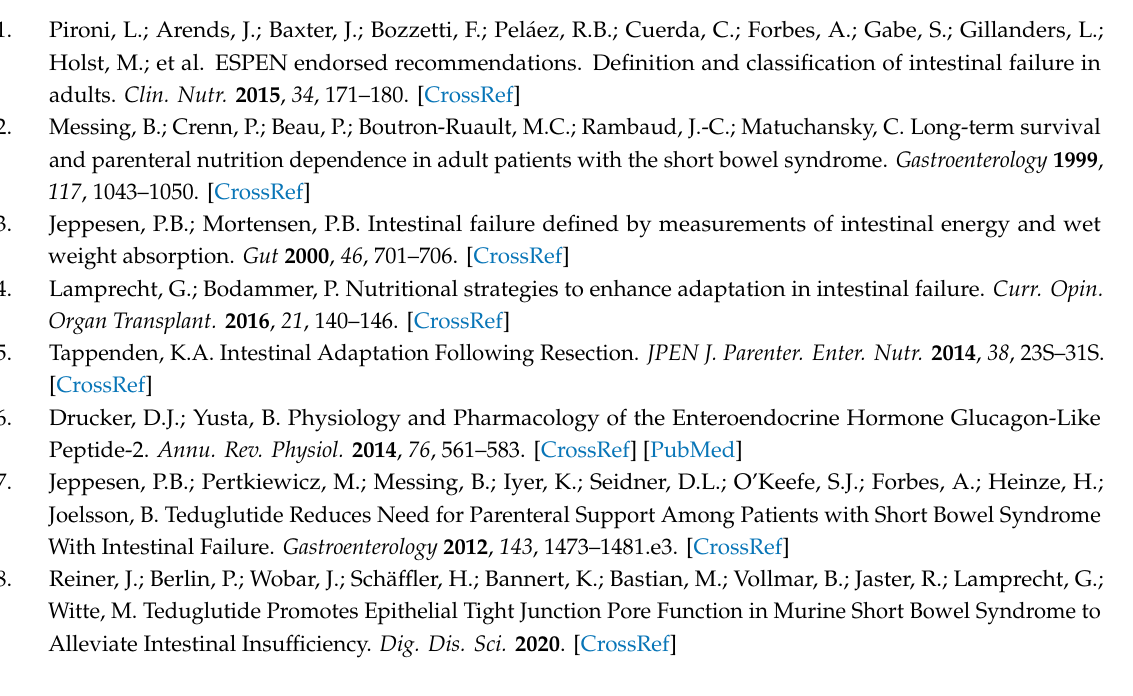
Figure A3: Urine sodium concentrations were available from 28 of 50 patients and were compared between the earliest and the latest measurement (similar to FIRST and LAST). ( A ): Urine sodium concentration significantly increased between the earliest and the latest measurement (* p < 0.05; Wilcoxon test). ( B ): Of note, urine sodium concentration was initially below 20 mmol/L in 9 patients; in 7 of these patients urine sodium concentration increased to values above 20 mmol/L as a result of changes in the composition of parenteral support.